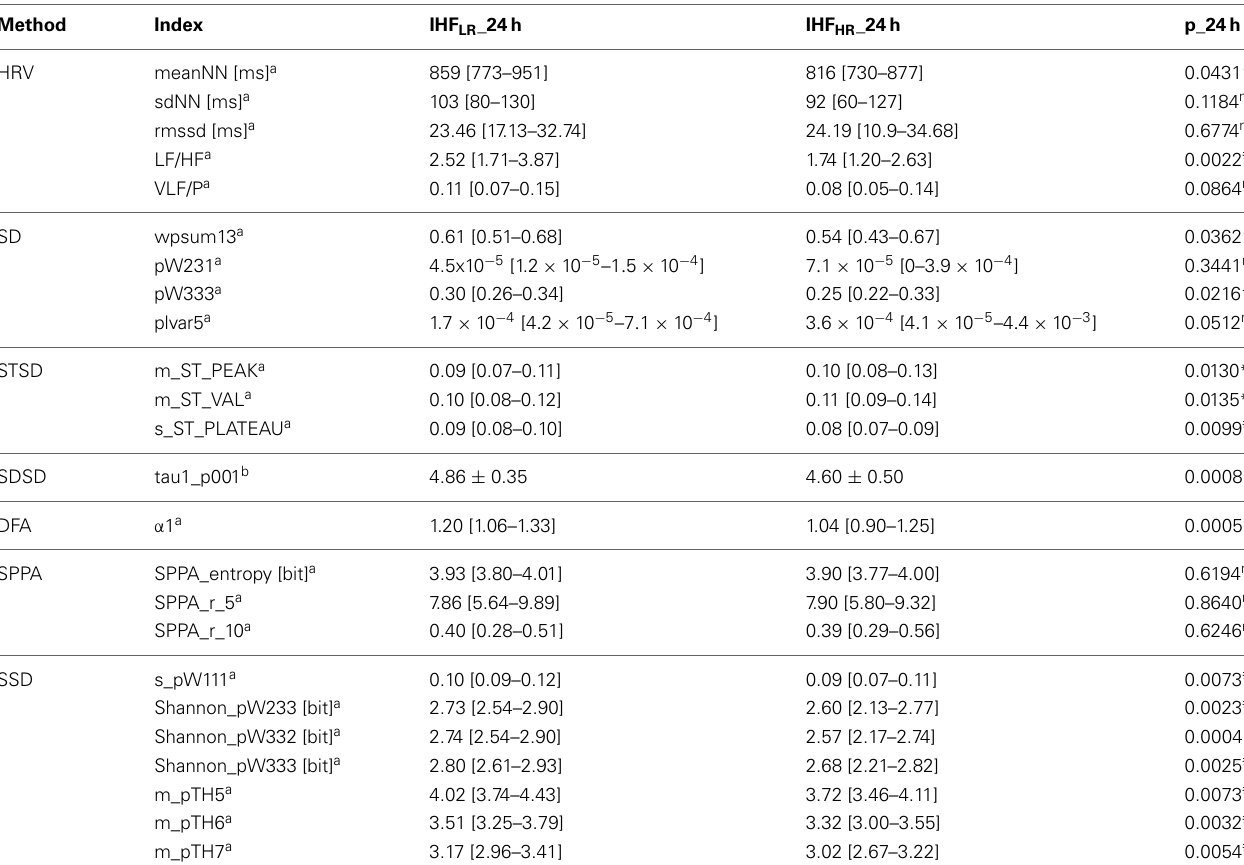
Table 2 | Analysis of 24h Holter ECGs: univariate statistical analysis results ( U -test) to discriminate between patients with ischemic heart failure at low risk and at high risk (IHF LR and IHF HR